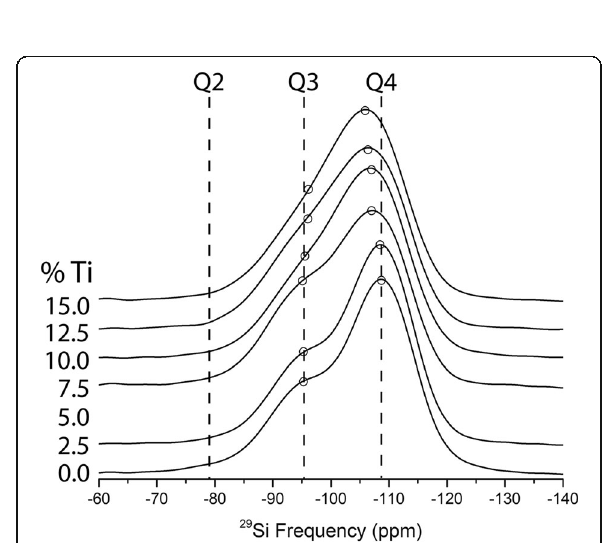
Fig. 4 Stacked 29 Si NMR data for NS8 glass at various Ti concentrations, normalized by integrated intensity. Peaks at − 96 and − 109 ppm are Q 3 and Q 4 , respectively. Compared with the NS4 glasses, Ti-free NS8 glass exhibits a more pronounced Q 4 peak, as is predicted based on the Na:Si of the glass. As with the NS4 glasses, there is a progressive positive shift in peak energy of the Si Q 4 peak, likely as a result of Ti nearest neighbors for the Si Q 4 species. Open circles are fitted peak